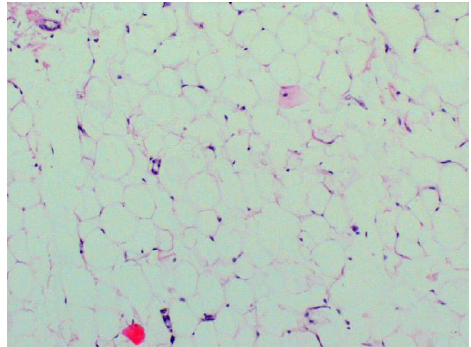
Figure 3. Normal adipose tissue (H&E, ×